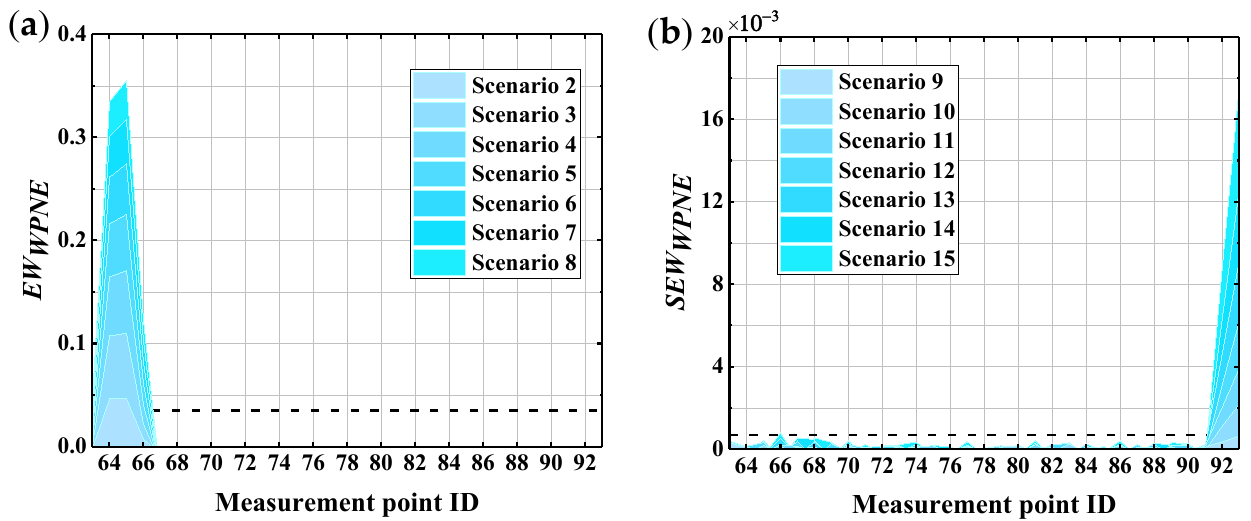
Figure 21. Results of the damage indexes when SNR = 60 and n = 60: ( a ) EW WPNE ; ( b ) SEW WPNE . To perform quantitative analysis of the noise resistance of EW WPNE and SEW WPNE at different SNR levels, according to the Monte Carlo simulation theory, the noise resistance performance quantification index NII (Noise Immunity Index) was defined. NII is com- posed of Missing Report Rate ( MRR ) and False Report Rate ( FRR ), and NII is defined